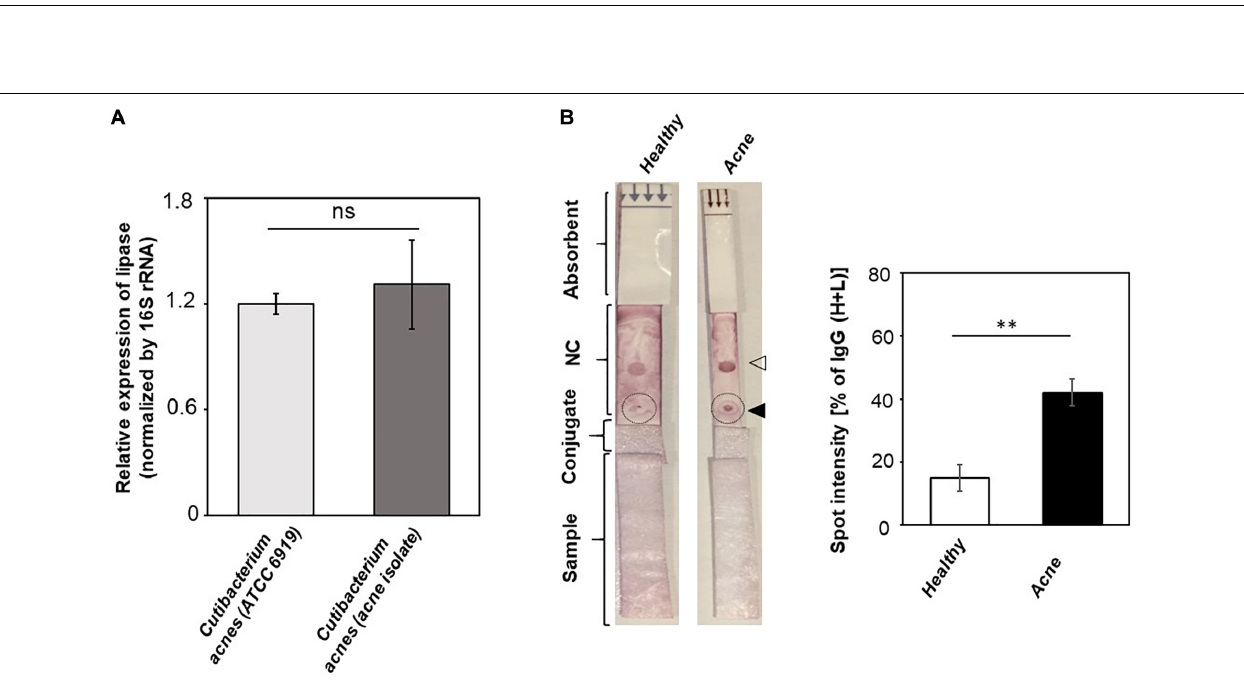
Frontiers in Microbiology |